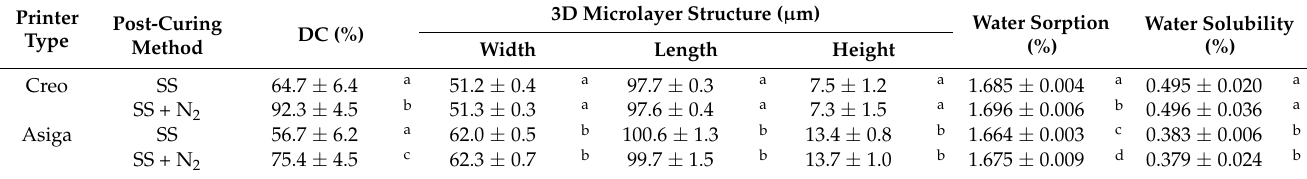
Figure 2. Typical load deflection curve for each group. Note that all specimens are broken in aged Asiga subgroups while no specimen are broken in non-aged Asiga subgroups, and a positive effect of the post-curing at a nitrogen gas (N 2 ) atmosphere is found only in aged Creo subgroups. Table 3. Mean value and standard deviation of DC, 3D microlayer structure, water sorption, and water solubility, and the results of one-way ANOVA statistical analysis.